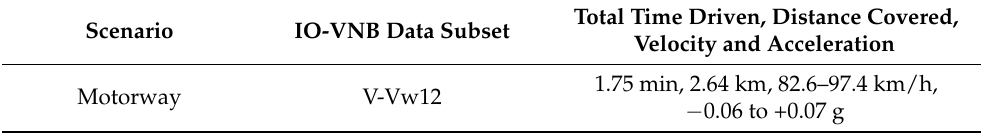
Table 2. IO-VNB data test subset used in the less challenging